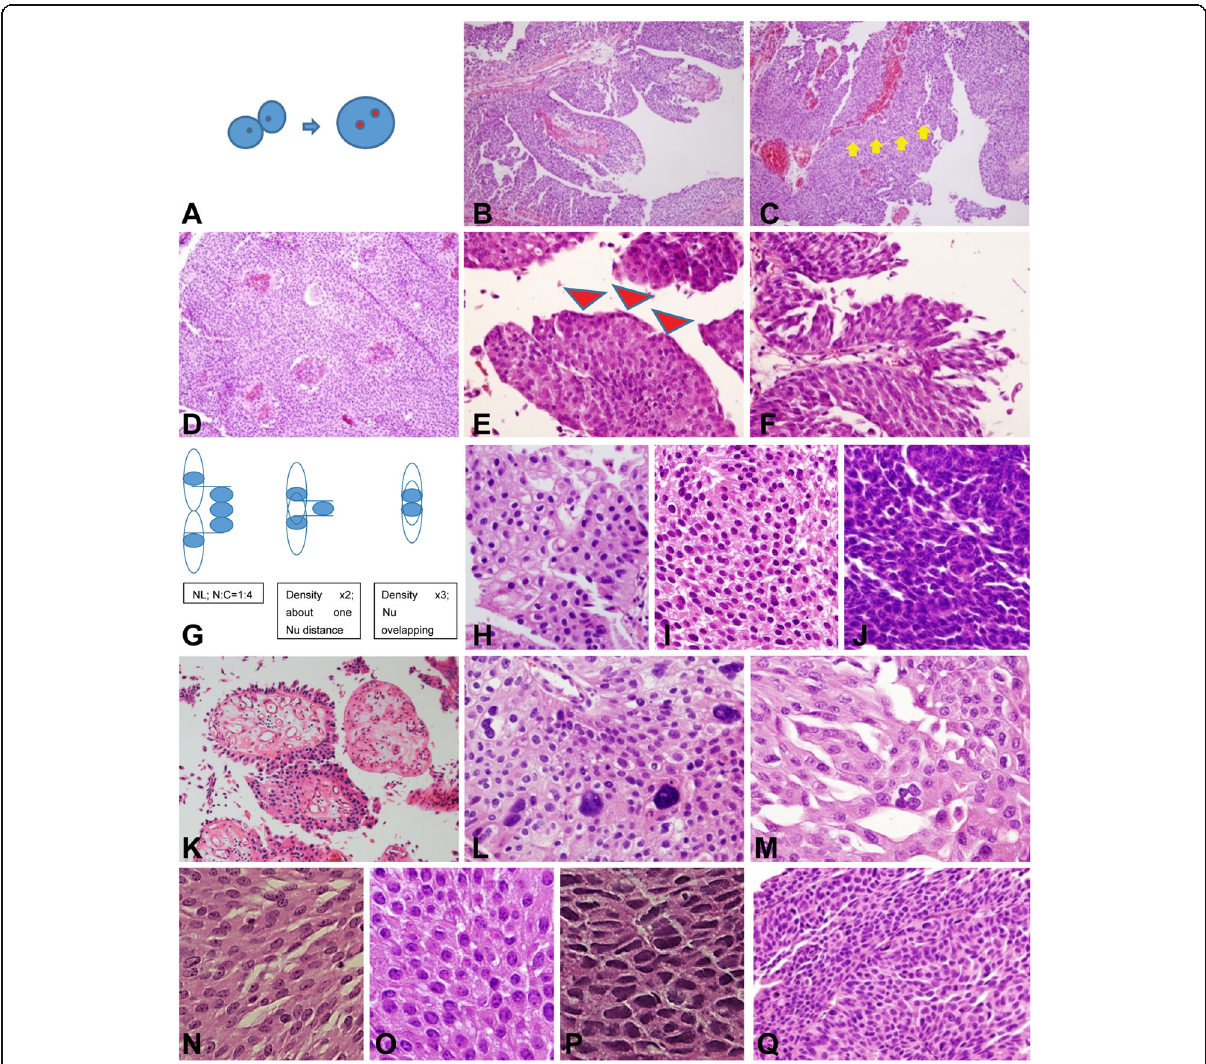
of umbrella cells. g Schematic figure for the estimation of cell density based on the distance between cells. h Cell density score 1. i Cell density score 2. j Cell density score 3. k Discohesiveness ( l ). Nuclear pleomorphism category 4 based on a difference between the smallest and the biggest nucleus of the tumor cells of about 20-fold. m Multinucleated giant cells. n Mild nuclear hyperchromasia. o Moderate nuclear hyperchromasia. p Severe nuclear hyperchromasia. q Polarity loss score